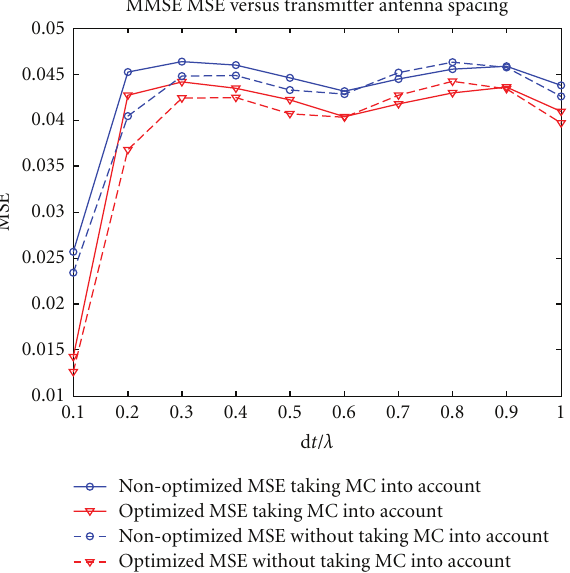
Figure 7: Optimized and nonoptimized MMSE MSE versus transmitter antenna element spacing with and without taking mutual coupling e ff ects into account.